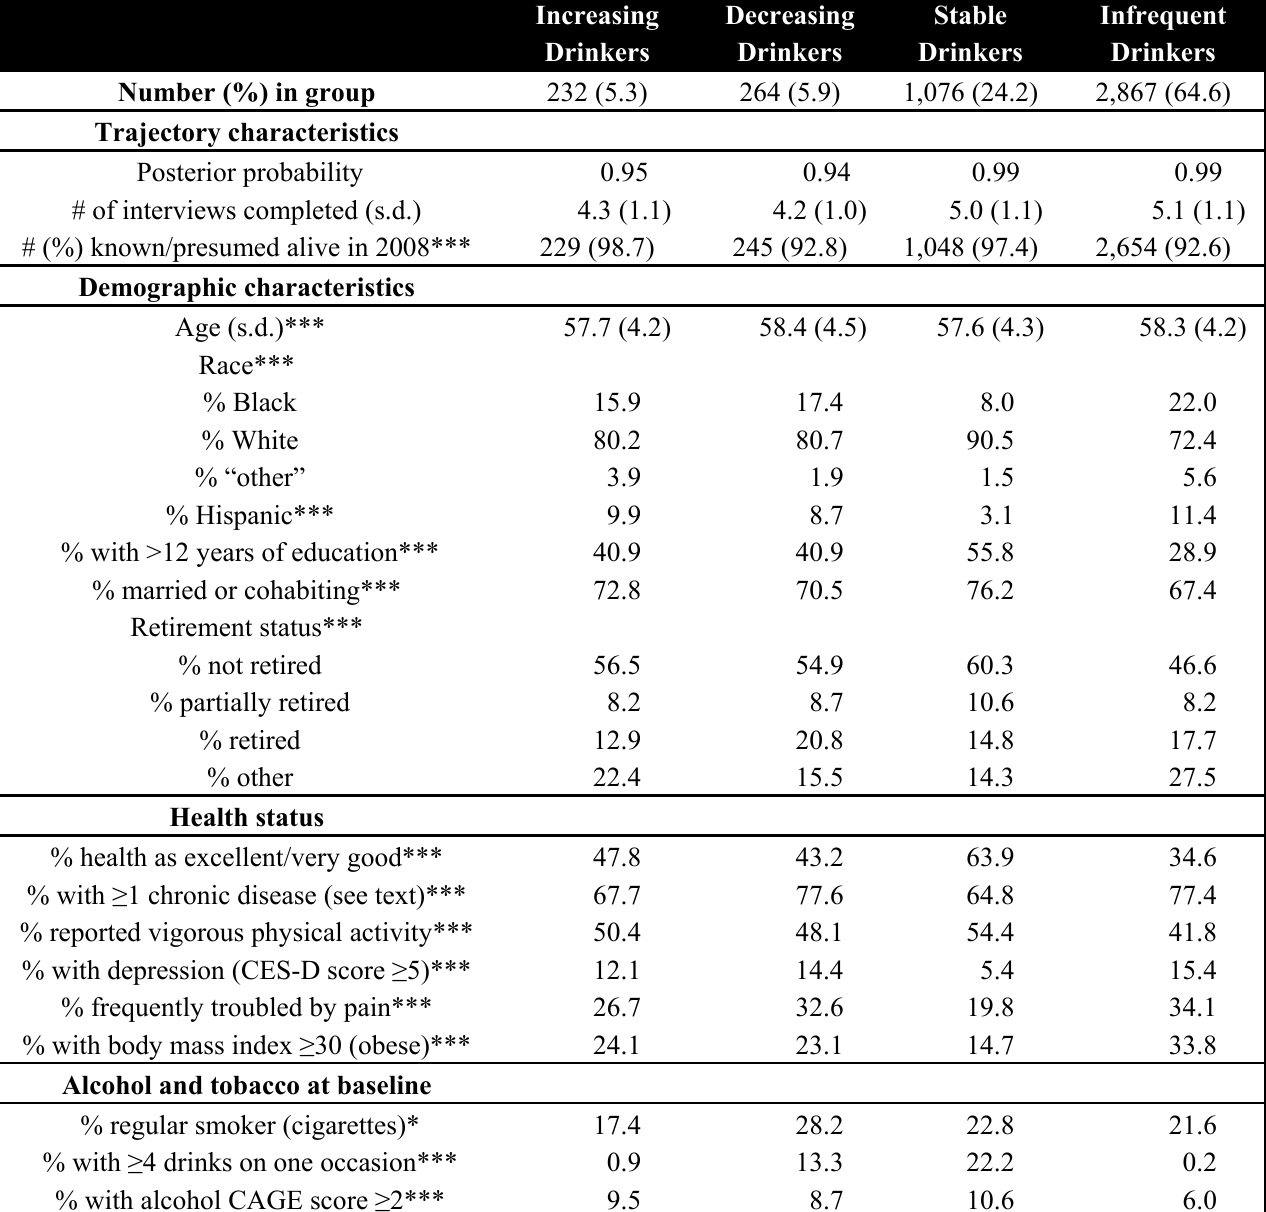
Table 1. Characteristics of alcohol use trajectory groups including study participation and demographic, health, and alcohol/tobacco use history at baseline (1998) among 4,439 women in the Health and Retirement Study. † Increasing Decreasing Stable Infrequent Drinkers Drinkers Drinkers Drinkers Number (%) in group 232 (5.3) 1,076 (24.2) 2,867 (64.6) Trajectory characteristics Posterior probability 0.95 0.94 0.99